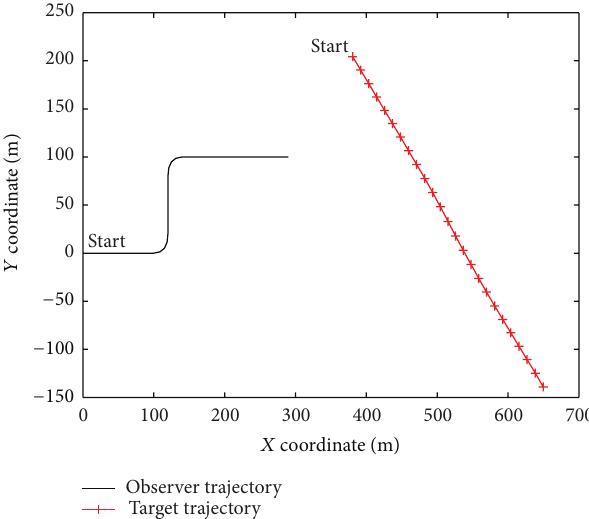
Figure 2: The observer trajectory and the target trajectory in the